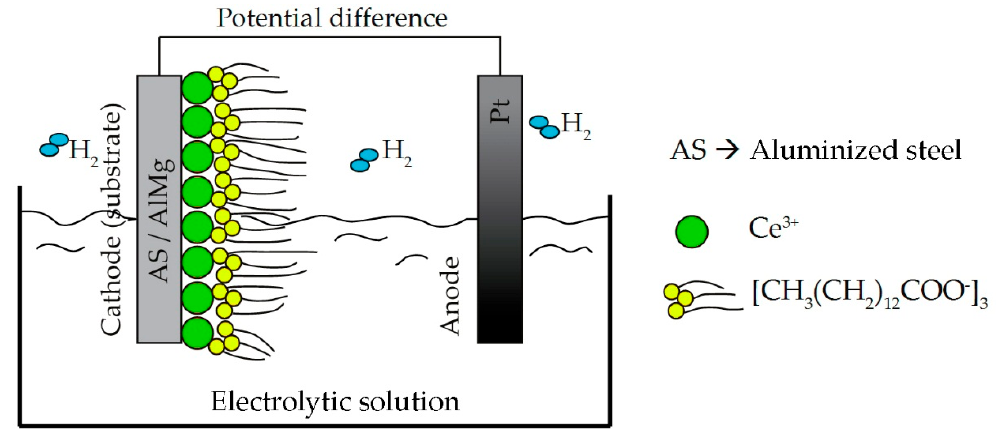
Figure 1. Diagram for the electrodeposition of cerium-based coatings on Al-Mg and AS samples.